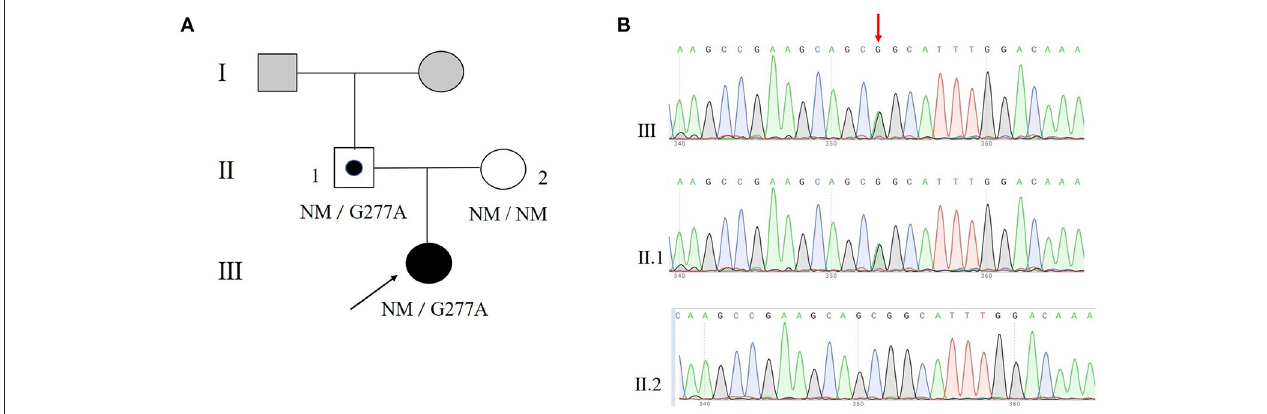
FIGURE 1 | A novel mutation of MKRN3 in a central precocious puberty (CPP) patient. (A) Pedigree of a family with a novel c.227G > A mutation in the human MKRN3 gene. (B) Partial sequencing chromatographs of the MKRN3 gene of the CPP patient and her family members. Squares indicate male family members; circles, female family members; black, individuals with CPP; gray, individuals CPP status unknown; symbol with black dot inside, asymptomatic carriers; NM, no mutation allele. The arrow indicates the proband.